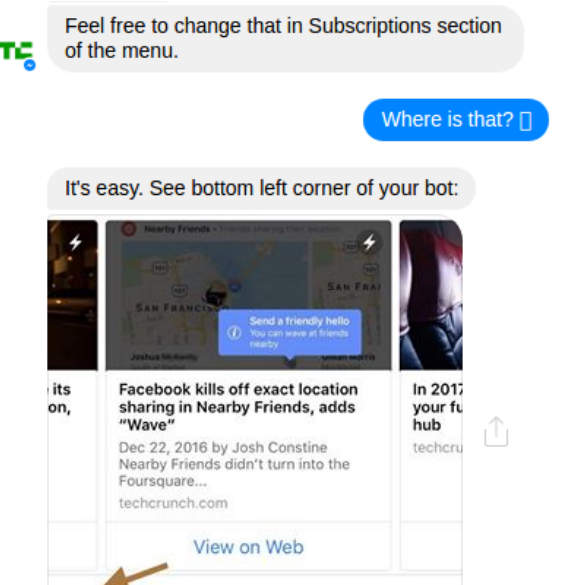
Fig. 17. CNN’s example of